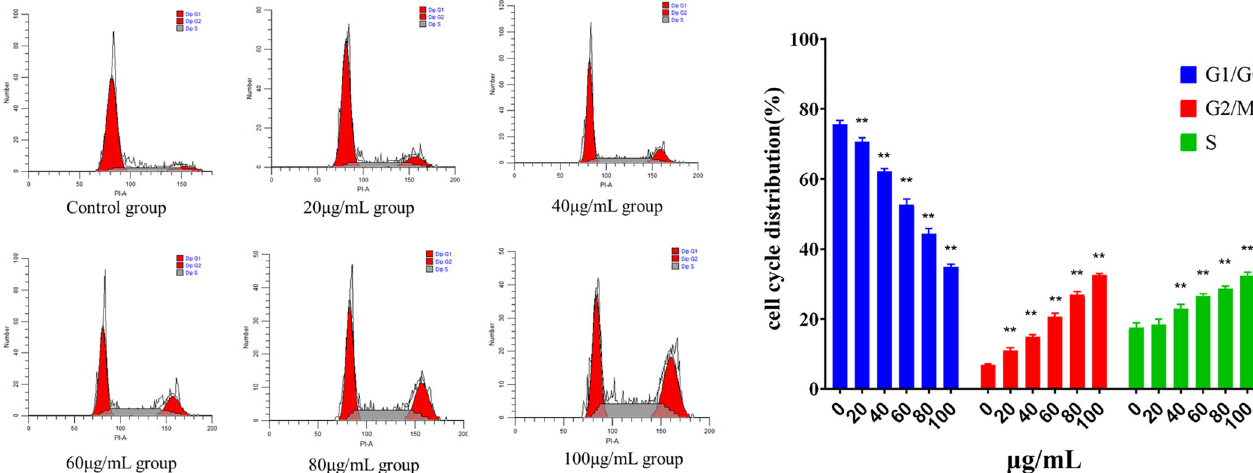
Fig 5. Effect of lingonberry extract on the apoptosis cycle of HepG2 cells. ( a ) Effect of lingonberry extract concentration on the cell cycle. ( b ) Analysis of cell apoptosis cycle in lingonberry treatment and control groups ( � p < 0.05, �� p < 0.01 compared to the control group).